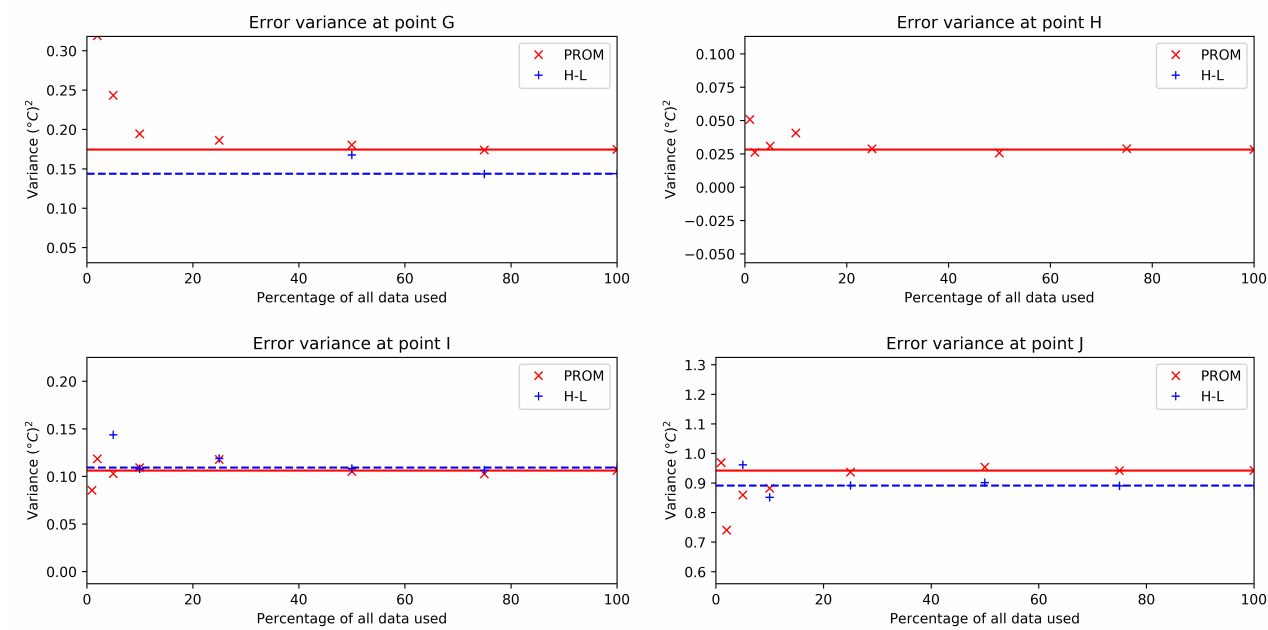
Figure 8. Comparison of H-L and PROM methods. Each plot represents results obtained from many numerical experiments realised at each location (see Figure 2 on page 9) showing comparisons of the computed variance (red × for PROM method, blue + for H-L). The respective horizontal lines are located at the value of the variance obtained for 100% in each method.